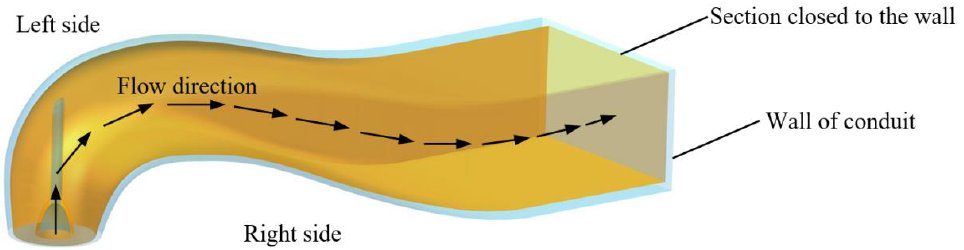
Figure 12. Schematic diagram of section position.